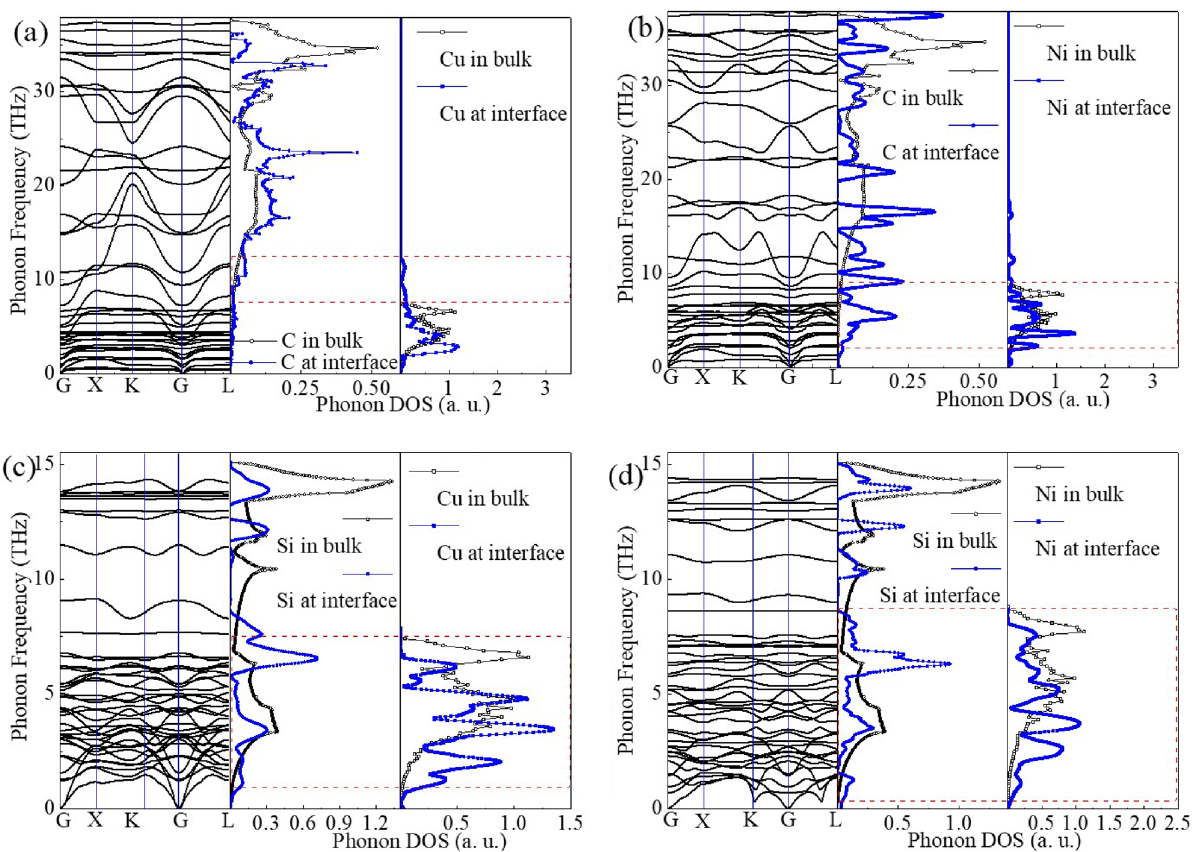
Figure 4. ( a ) Phonon dispersion curves and phonon DOS of the interfacial atoms for ( a ) the Cu–C, ( b ) the Ni–C, ( c ) the Cu–Si, ( d ) the Ni–Si interfaces. The phonon DOS of the atoms in bulk are also